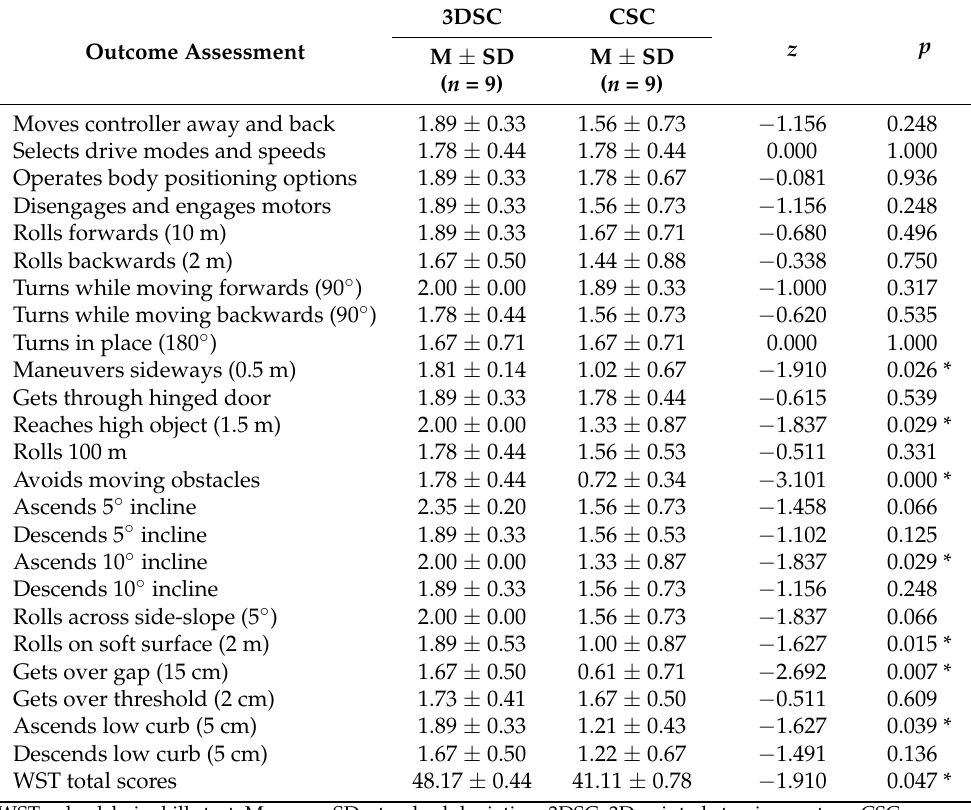
Table 4. Comparison of the WST Performances (Version 4.2) in each system-Female ( n = 9).